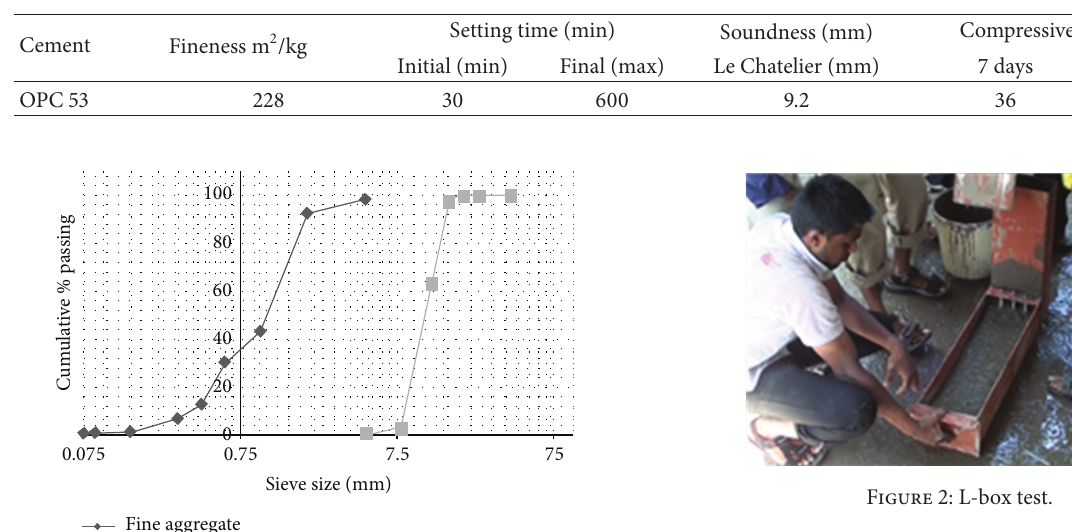
Table 1: Results of test on cement.